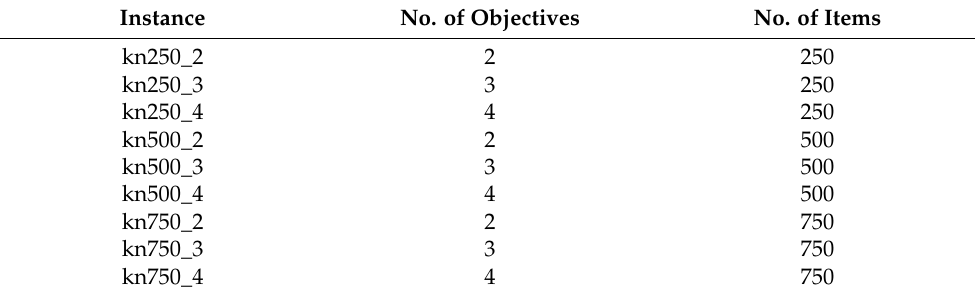
Table 3. The features of MKP datasets for MBABC-NM.